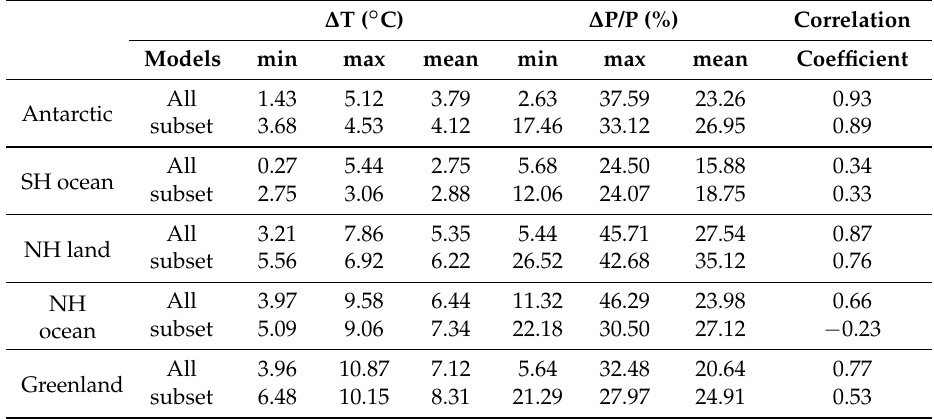
Figure 6. Regional-mean precipitation change ( ∆ P/P) with respect to surface temperature change ( ∆ T) for all-models. The subset of selected models in each region is shown by filled-circles, so it can be distinguished from the rest of the models shown by empty circles. The changes are based on comparing the current (1976–2005) and future (1971–2100) climates. Table 2. Statistics for surface temperature and percent relative precipitation change for all and subset models. The table is constructed using the same data plotted in Figure 6.